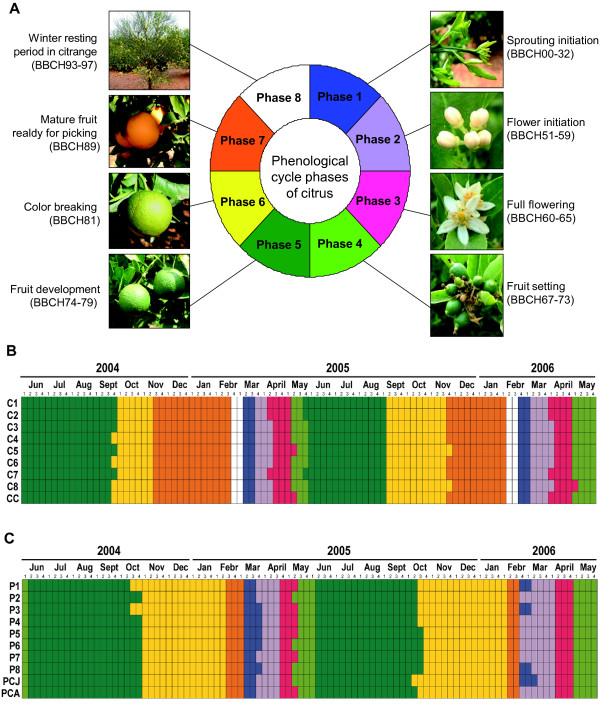
Phenological assessment. A) Schematic representation of the phenological cycle of the citrus lines. The main phases of development are shown using different colors (key legend), which were used to draw the phenological calender of B) the Carrizo citrange lines and C) the Pineapple sweet orange lines. Phenological stages were recorded weekly according to the BBCH codification for citrus and grouped into 8 phases stressing flower and fruit developmental stages.